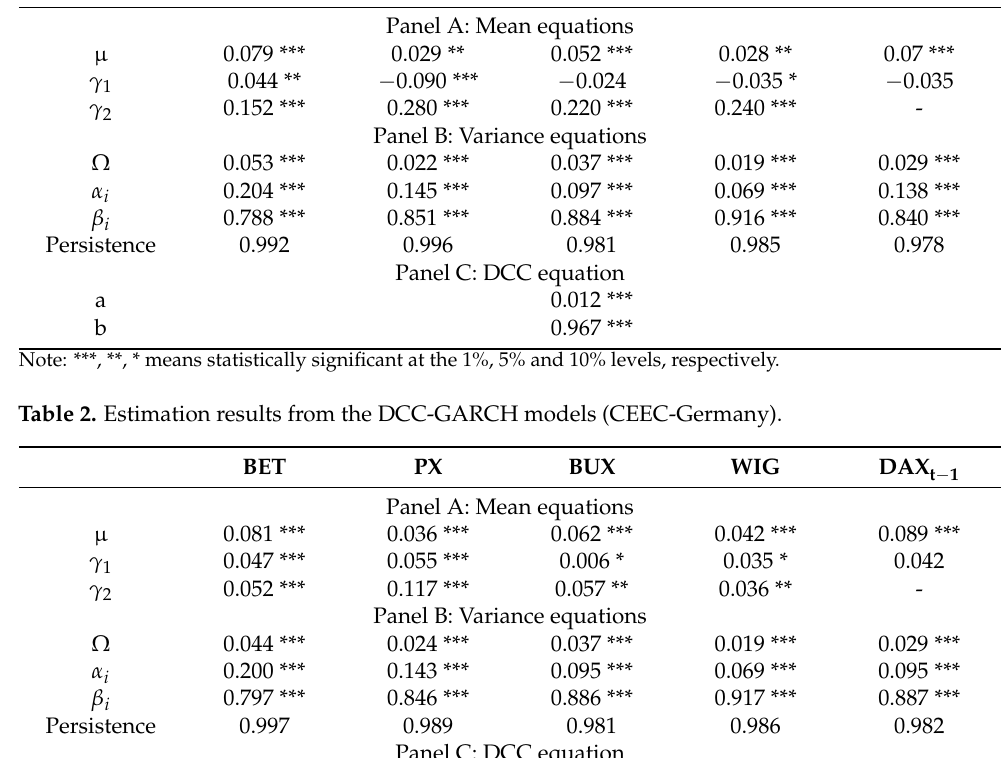
Table 1. Estimation results from the DCC-GARCH models (CEEC-USA). BET